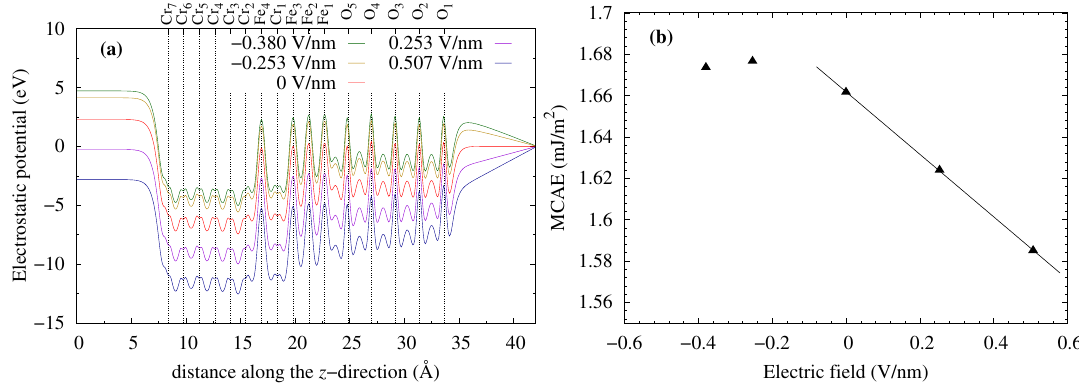
Figure 8. ( a ) Electrostatic potential in structure-II for η Fe = dependence in structure-II for η Fe =